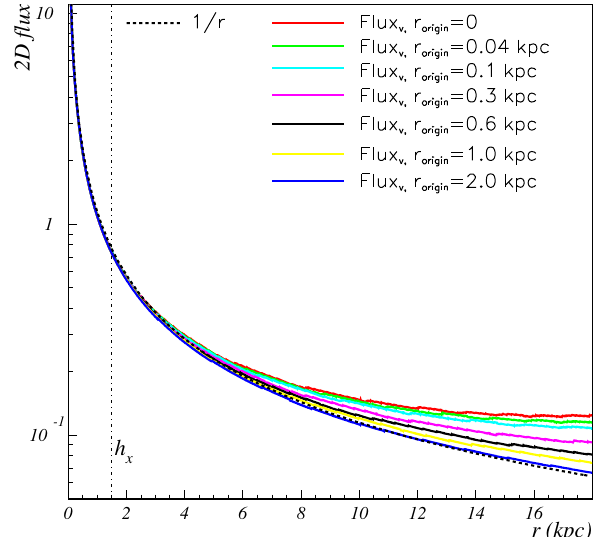
Fig. 7 Two-dimensional flux F h vs. galactic radius r . F h is calculated for various points of origin r origin along r . The result in red is for F h originating from the galaxy center, r = 0, as depicted in Fig. 3. The green curve is for F h originating at a point at r = 0 . 04 kpc. The points of origin for the other curves, from 0.1 to 2 kpc, are given in the figure. The results are for the galactic parameters listed in Fig. 4. The radial characteristic scale h r = 1 . 5 kpc is shown by the vertical dot-dashed line. The dashed curved is the Newtonian 1 / r two-dimensional flux. The effect of field self-interaction is noticeable for fluxes originating at r